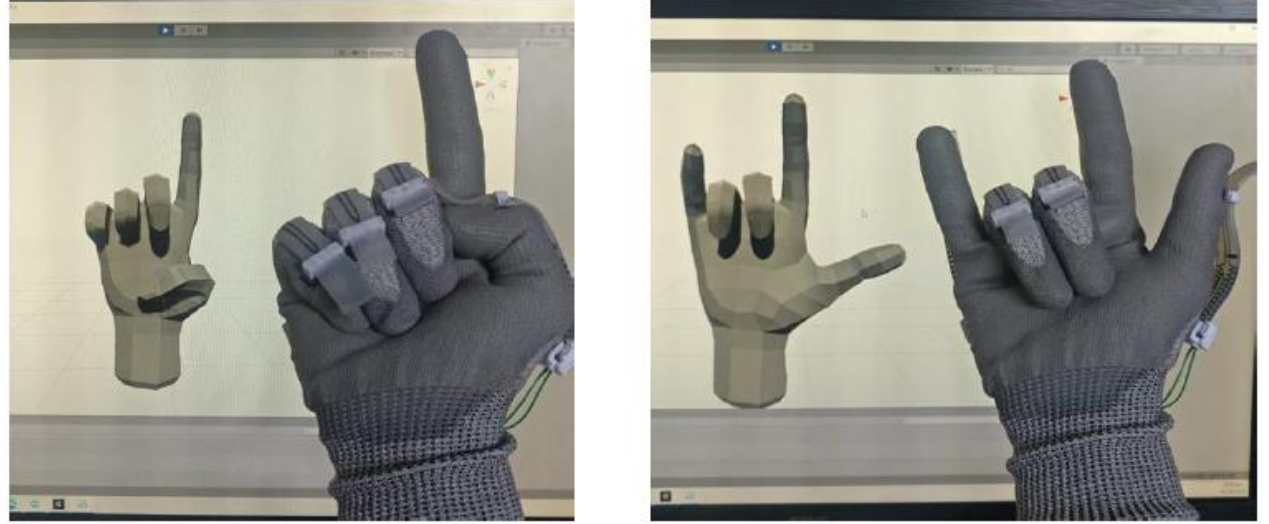
Figure 8. Examples of hand gestures and their presentation on the computer screen.